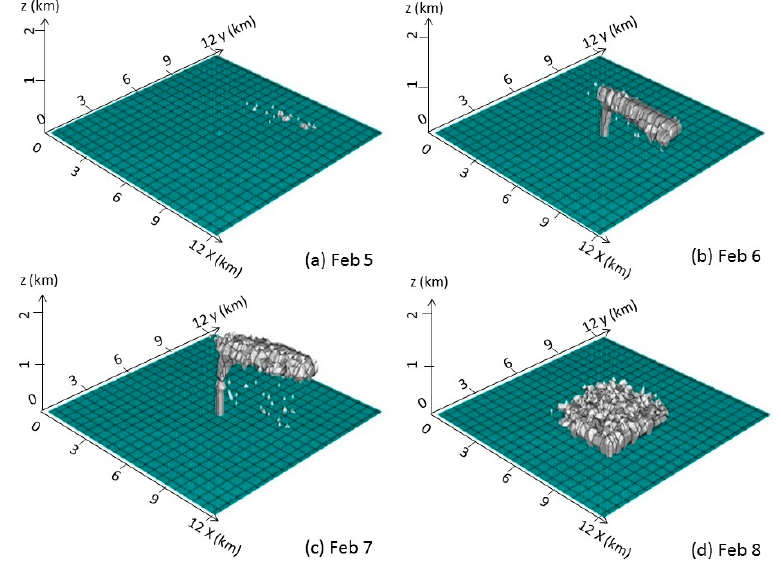
Figure 7. Smoke plumes at Stewart on 5–8 February at 1200 local time ( a – d ) simulated with Daysmoke. The burn site is located at the center grid